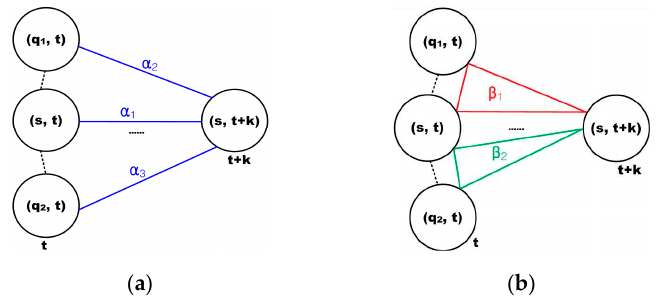
Figure 10. Model parameters at each cone zone: ( a ) description of the clique parameters at two-pair cliques and ( b ) illustration of the clique parameters for the triplet cliques.